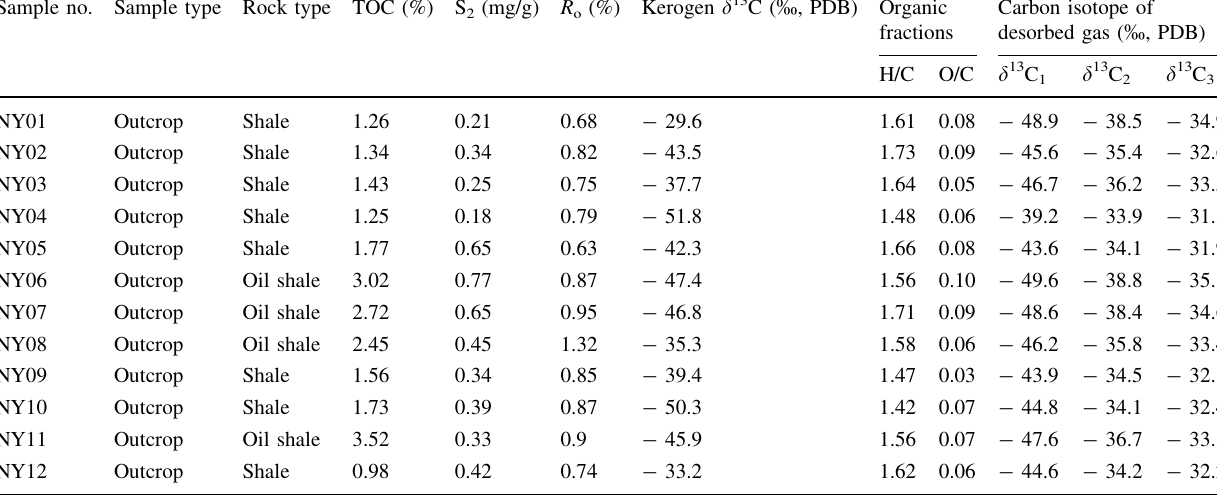
Table 1 Sample information, organic geochemical data and isotopic compositions of shale samples